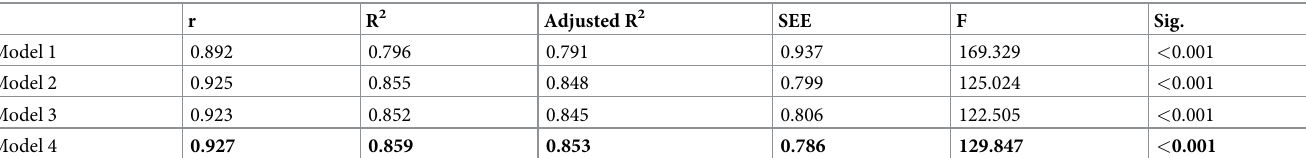
SEE, standard error of the estimate. Model 1: weight and height; Model 2: weight, height, and thickness of the biceps brachii and rectus femoris; Model 3: weight, height, and echo intensity to muscle thickness ratio of the biceps brachii and rectus femoris; Model 4: weight, height, thickness of the rectus femoris, and echo intensity to muscle thickness ratio of the biceps brachii.